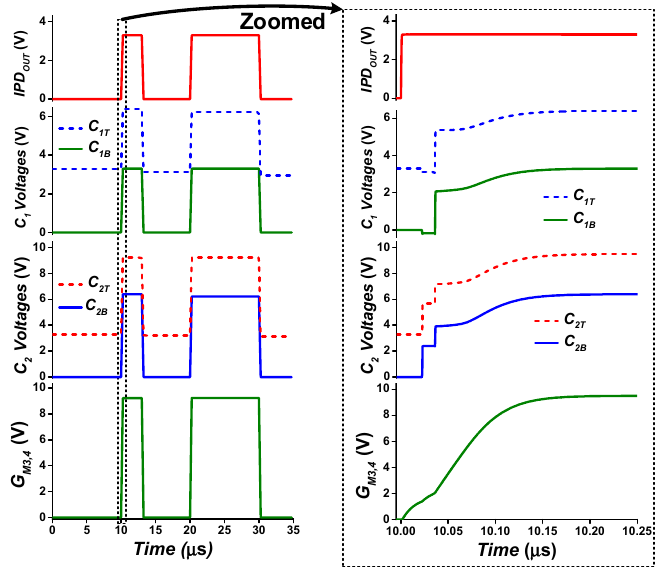
Figure 12. Two-stage bootstrap driver operation waveform.